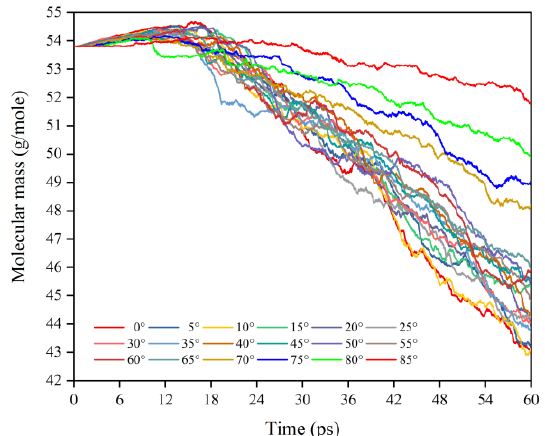
Figure 6. Snapshots of AO impacting Kapton at different incidence angles during the initial phase (1 ps) and the termination phase (60 ps).